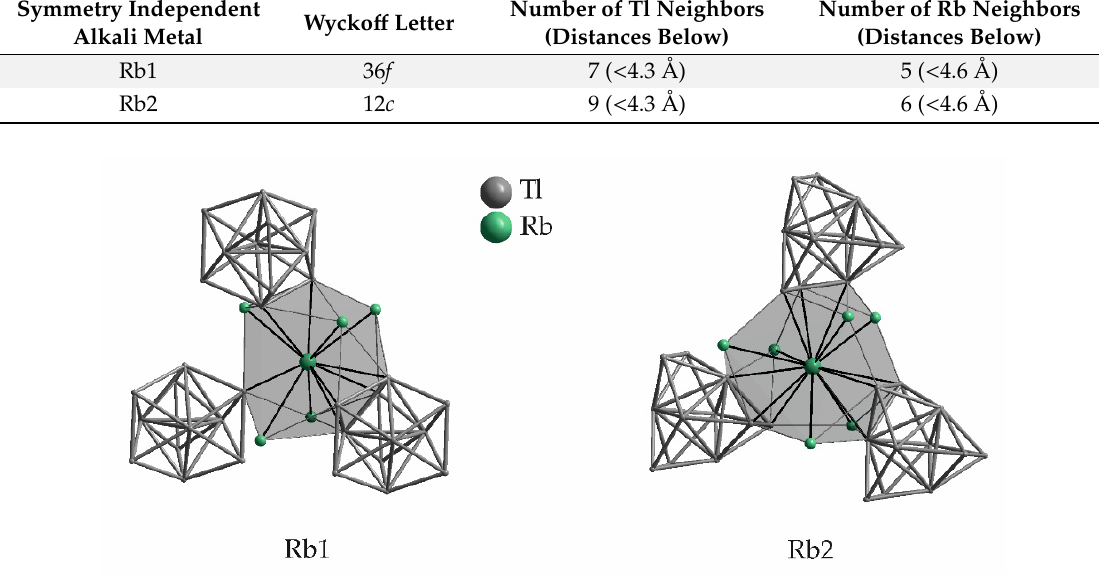
Figure 7. Surroundings of the two symmetry inequivalent rubidium positions in Rb 8 Tl 11 . The corresponding range of distances to the adjacent atoms as well as the Wyckoff letters are given in